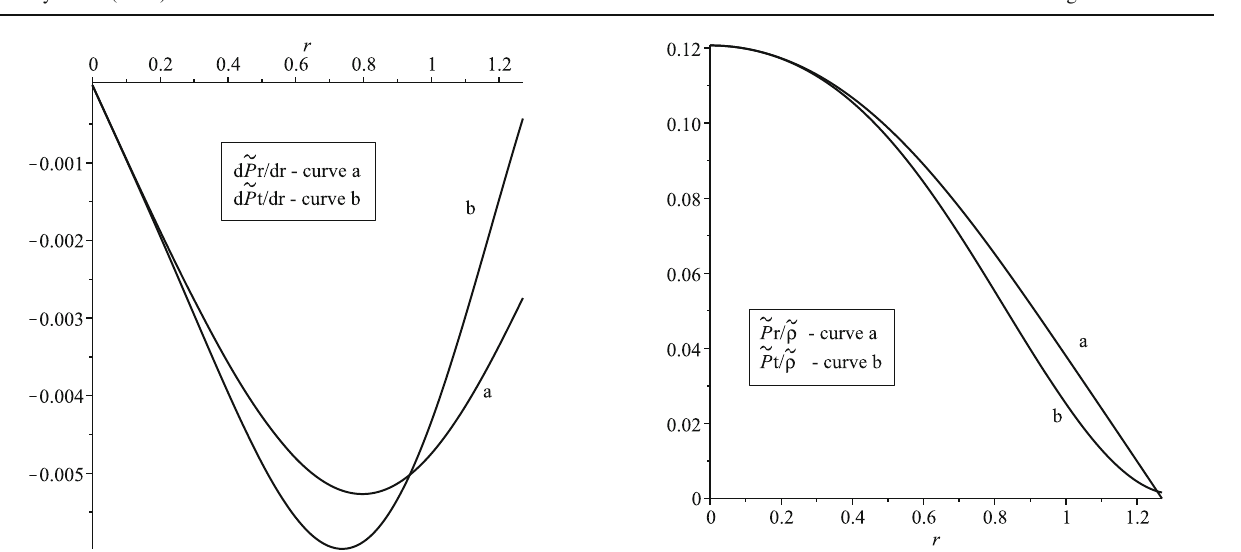
Fig. 15 Gradients of the pressures for the solution obtained with the second algorithm with ˜ F = 0 from the isotropic Gold III solution